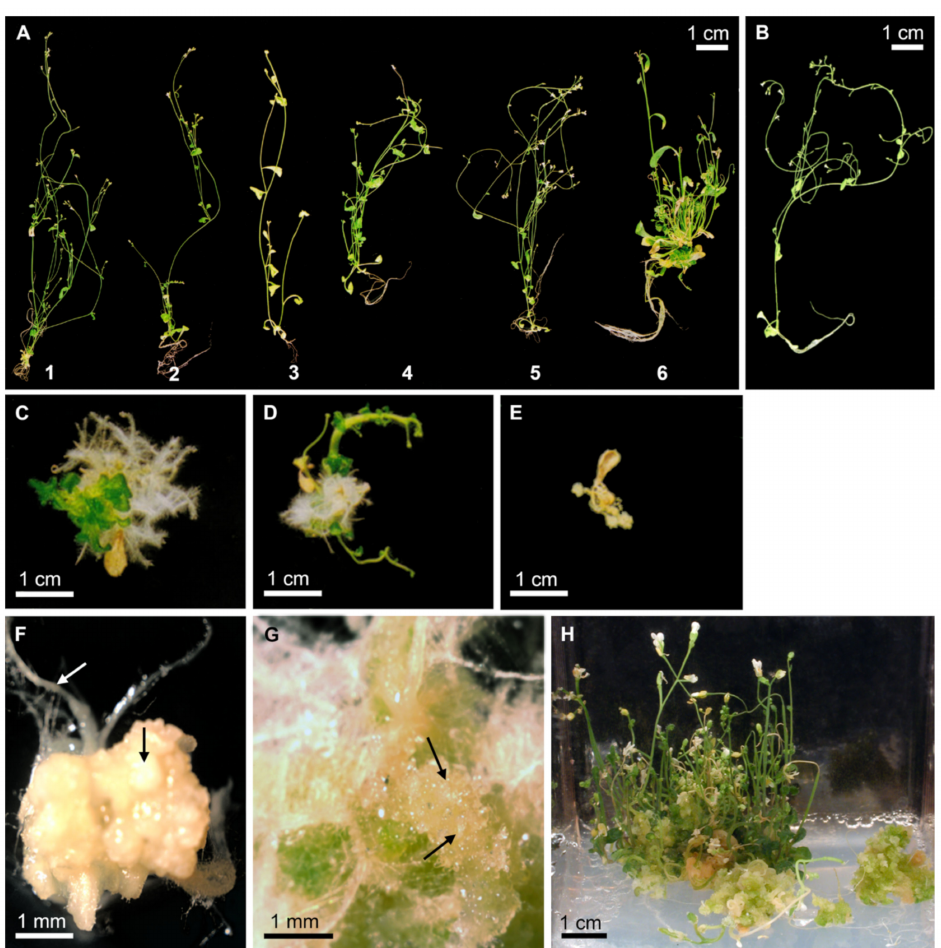
Figure 1. Morphology of Arabidopsis lec1-1 PmLEC1 T1 lines containing the Douglas-fir PmLEC1 trans- gene. ( A ) Representative T1 lines displaying Arabidopsis seedlings with normal morphology (plants 1 to 5) or a bushy phenotype (plant 6). ( B ) Wild type seedling (control, non-transgenic). ( C ) Seedling with multiple cotyledon-like organs. ( D ) Seedling exhibiting fasciation-like symptoms with stunted lateral organs. ( E ) Germinated seedling that stopped further development and died. ( F ) Seedling with normal roots (white arrow) and non-embryogenic callus tissue (black arrow). ( G ) Seedling-derived callus resembling globular stage somatic embryos (arrows). ( H ) Regeneration of morphologically normal plants from an embryogenic callus that proliferated on half-strength MS medium without plant growth regulators for more than one